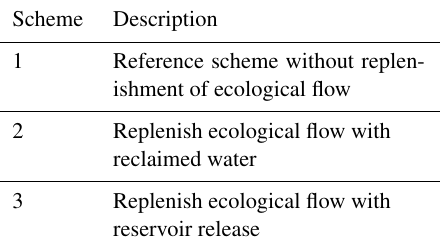
Table 2. Relationship between control sections and ecological units.